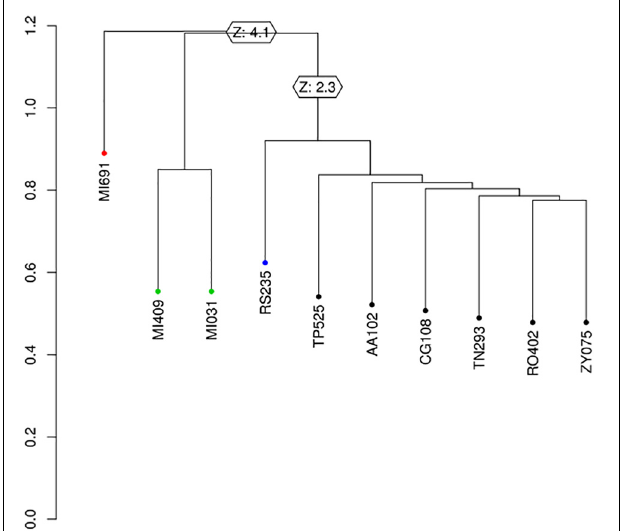
FIGURE 6 | Phylogenetic tree produced by SNprelate, z -score at supported